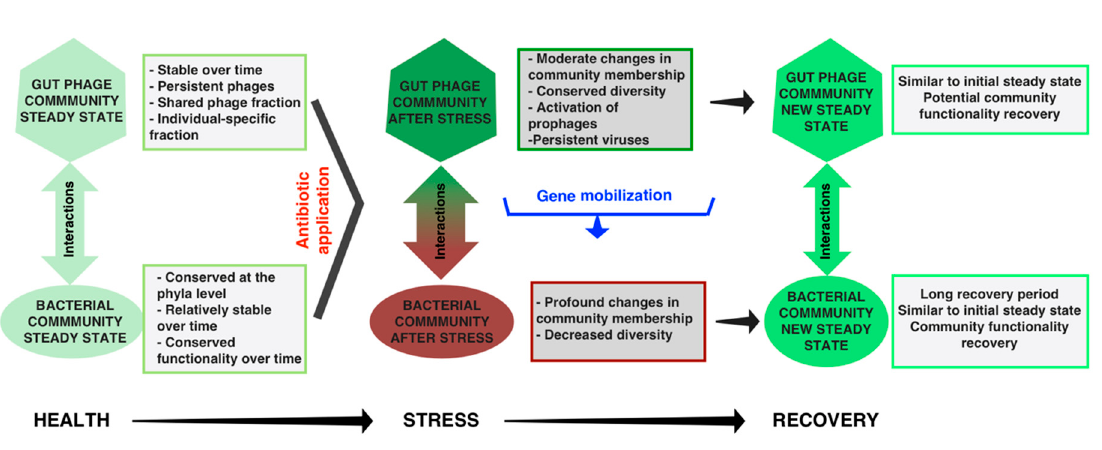
Figure 5. Phage community resilience and its contribution to the resilience of the bacterial community. A characteristic of a healthy microbiome is its ability to recover quickly from perturbations, after which a new “steady state” is established. Antibiotic administration results in profound changes in the microbial community, while changes in the viral community are only moderate. Phage–bacteria network interactions increase after perturbation and new networks are established in the new steady states. The phage component likely contributes to the recovery of the microbial community through the mobilization of beneficial genes.